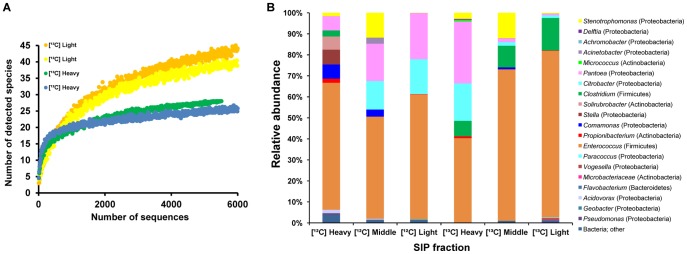
Bacterial diversity and relative abundance in the gut microbiota of early-instar larvae.(A) Rarefaction curves of 16S rDNA sequences were obtained from representative SIP fractions of the control ([12C]) and labeling treatment ([13C]). (B) Relative abundance of bacterial taxa in different SIP fractions, represented in a relative area graph as revealed by pyrosequencing. Abbreviations: [12C] Light, light fractions (fractions 9–11, Fig. 2A) of native-glucose amendment; [12C] Middle, middle fraction (fraction 7) of that; [12C] Heavy, heavy fractions (fractions 4–5) of that; [13C] Light, light fractions of 13C-glucose amendment; [13C] Middle, middle fraction of that; [13C] Heavy, heavy fractions of that.